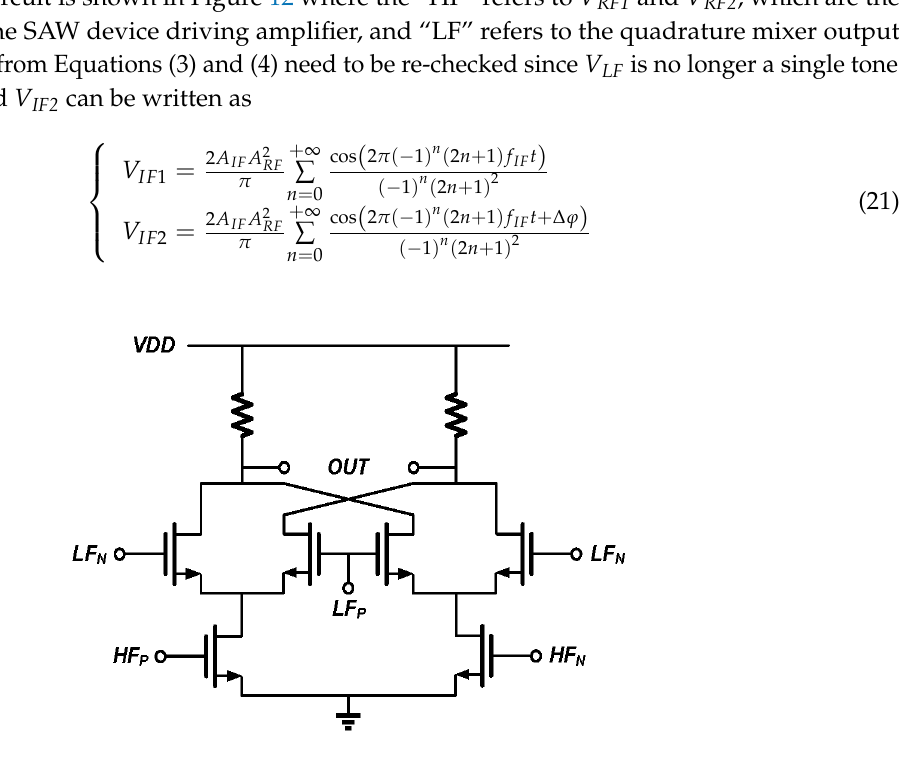
Figure 12. Circuit of the down-mixer. The inputs HF and LF are differential, and so is the output.